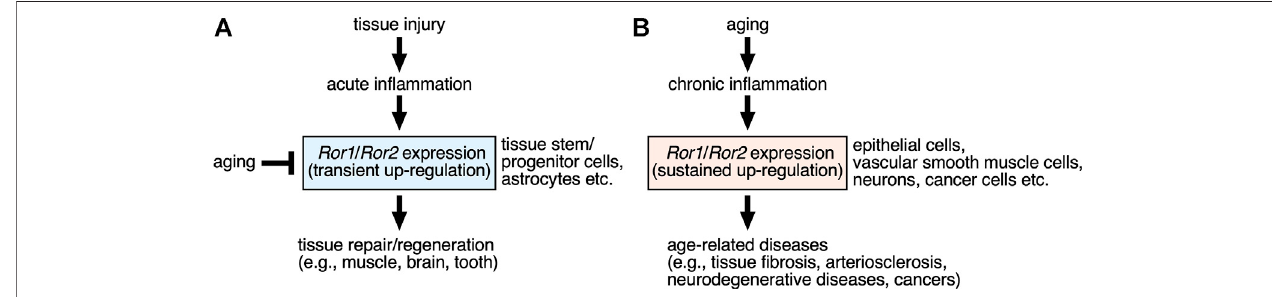
FIGURE 2 | | Possible roles of the Ror-family receptors up-regulated by injury and aging in the tissue repair/regeneration and the age-related diseases. (A) Expression levels of Ror1 and/or Ror2 are increased transiently in somewhat restricted (speci fi c) cells, including stem/progenitor cells and astrocytes, within the damaged tissues following injury, via environmental cues including in fl ammatory cytokines and growth factors. Up-regulated Ror1/Ror2 in turn contribute to the promotion of tissue repair or regeneration. Aging can mediate decreased expression of the Ror-family receptors in the tissue stem/progenitor cells, resulting in the dysfunctionofthesetissue stem/progenitor cellsinregulatingtissuerepair orregeneration. (B) SustainedexpressionofRor1and/or Ror2areinducedinvarioustypesof cellsunderchronicin fl ammationcausedbyaging,therebycontributingtothedevelopmentorprogressionoftheage-relateddiseases,including fi brosis,arteriosclerosis, neurodegenerative diseases, and various